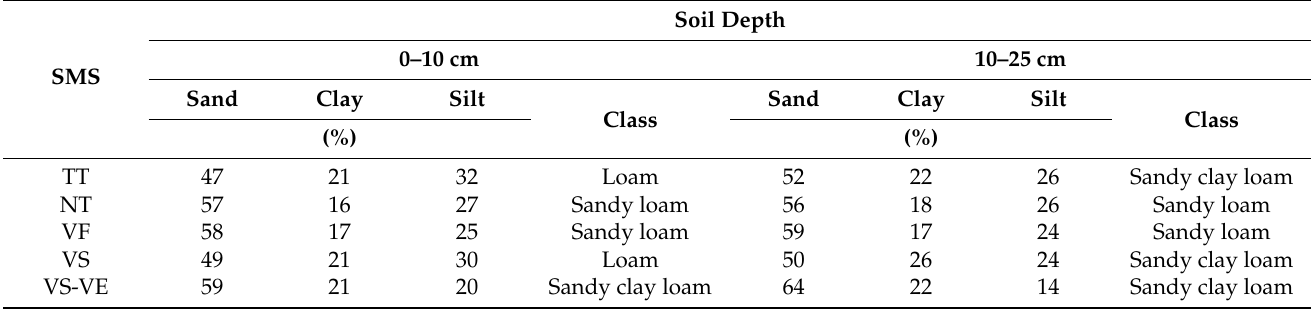
Table 1. Soil texture and composition at different depths for experimental plots under soil manage- ment strategies.